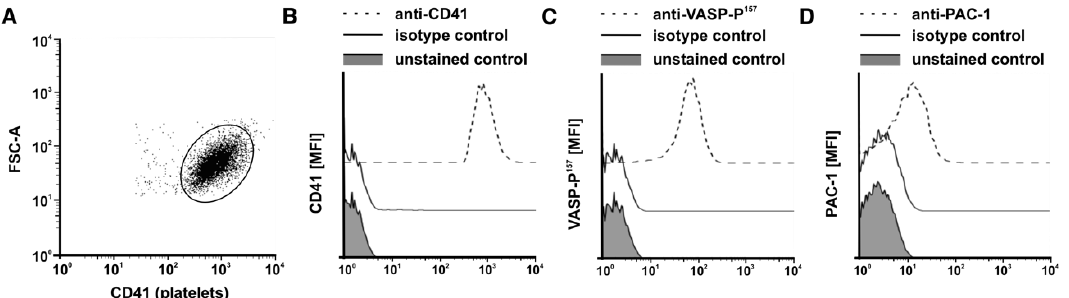
Figure A2. Gating strategies for cytometry analysis shown in Figures 3 and 4. ( A ) Human platelets were labeled with CD41 antibodies to exclude cellular debris and microparticles. Staining control of ( B ) anti-human CD41 antibodies, ( C ) anti-human VASP-P 157 , and ( D ) anti-human PAC-1 antibodies, as compared to isotype control and unstained sample.